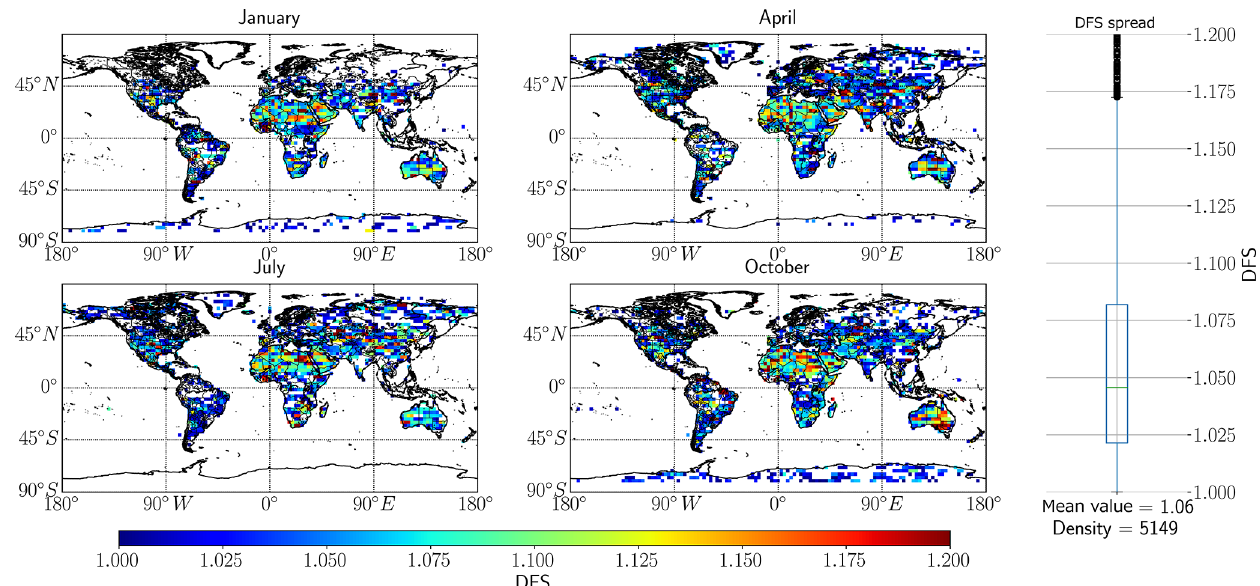
Figure 9. As Fig. 3 but focused on the Sentinel-5 SWIR3